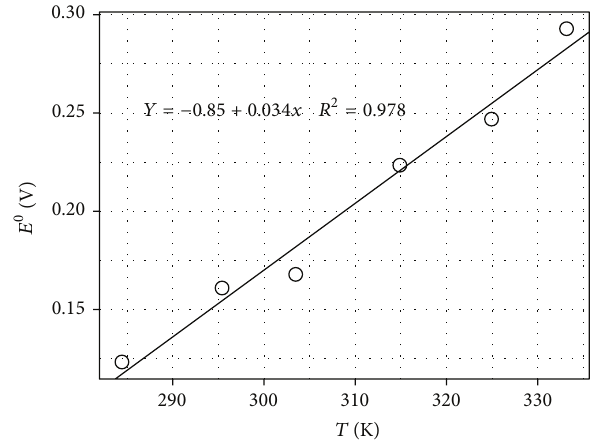
Figure 8: Michaelis-Menten representation of the amperometric response of catalytic activity of Mb/PMMA- b -PDMAEMA against H 2 O 2 in phosphate